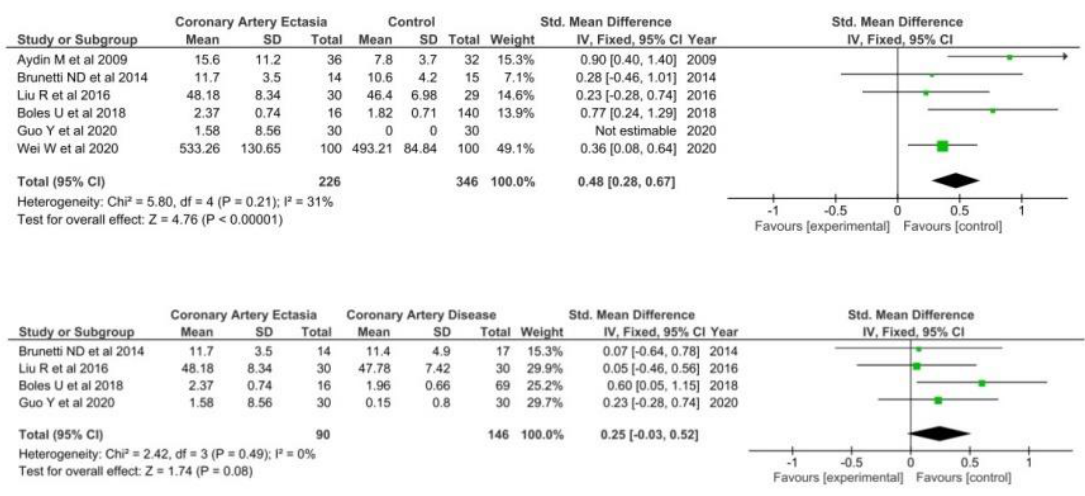
Figure 5. TNF-a in CAE patients versus controls (top) and CAE versus CAD patients